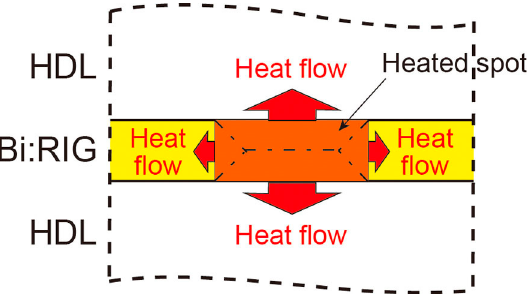
Figure 8. Concept of heat dissipation layer. Most of excess heat in Bi:RIG magnetic layer is diffused into HDLs to reduce heat diffusion in Bi:RIG.